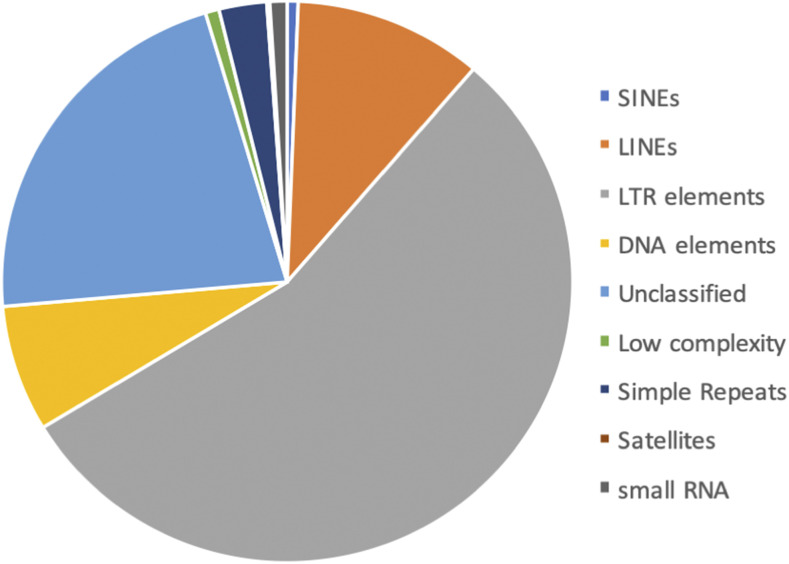
Interspersed repeats and low complexity elements representing 55.1% of the macadamia genome assembly.